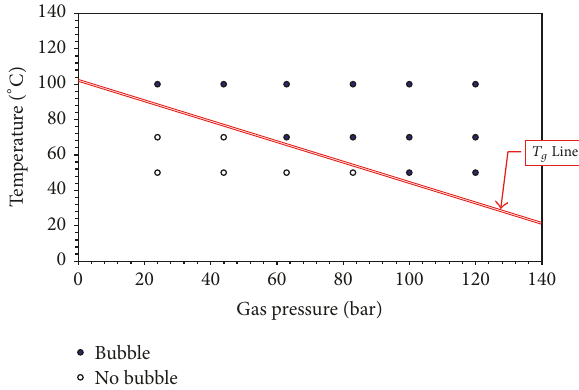
Figure 7: Incident of bubble formation and 𝑇 𝑔